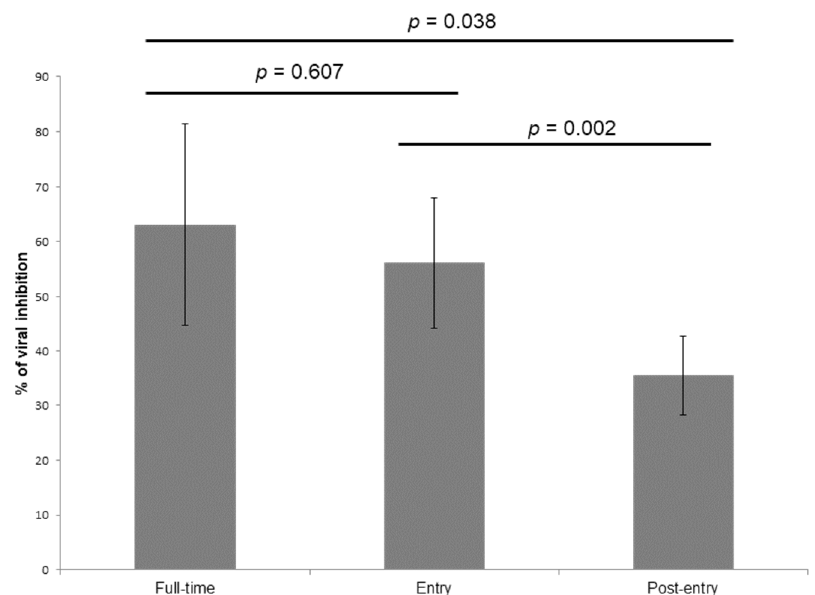
Figure 2. Antiviral activities of doxycycline at 5 µ M against the SARS-CoV-2 IHUMI-003 strain in vitro. For full-time treatment, Vero E6 cells were pre-treated with doxycycline for 4 h and virus was then added for 48 h. For “entry” treatment, doxycycline was added to Vero E6 cells 4 h before viral infection and the virus-doxycycline mixture was replaced with fresh medium after 2 h post infection and was maintained for 46 h. For “post-entry” treatment, doxycycline was added 2 h post infection and was maintained for 46 h. Error bars represent the standard deviation of 10 experiments.